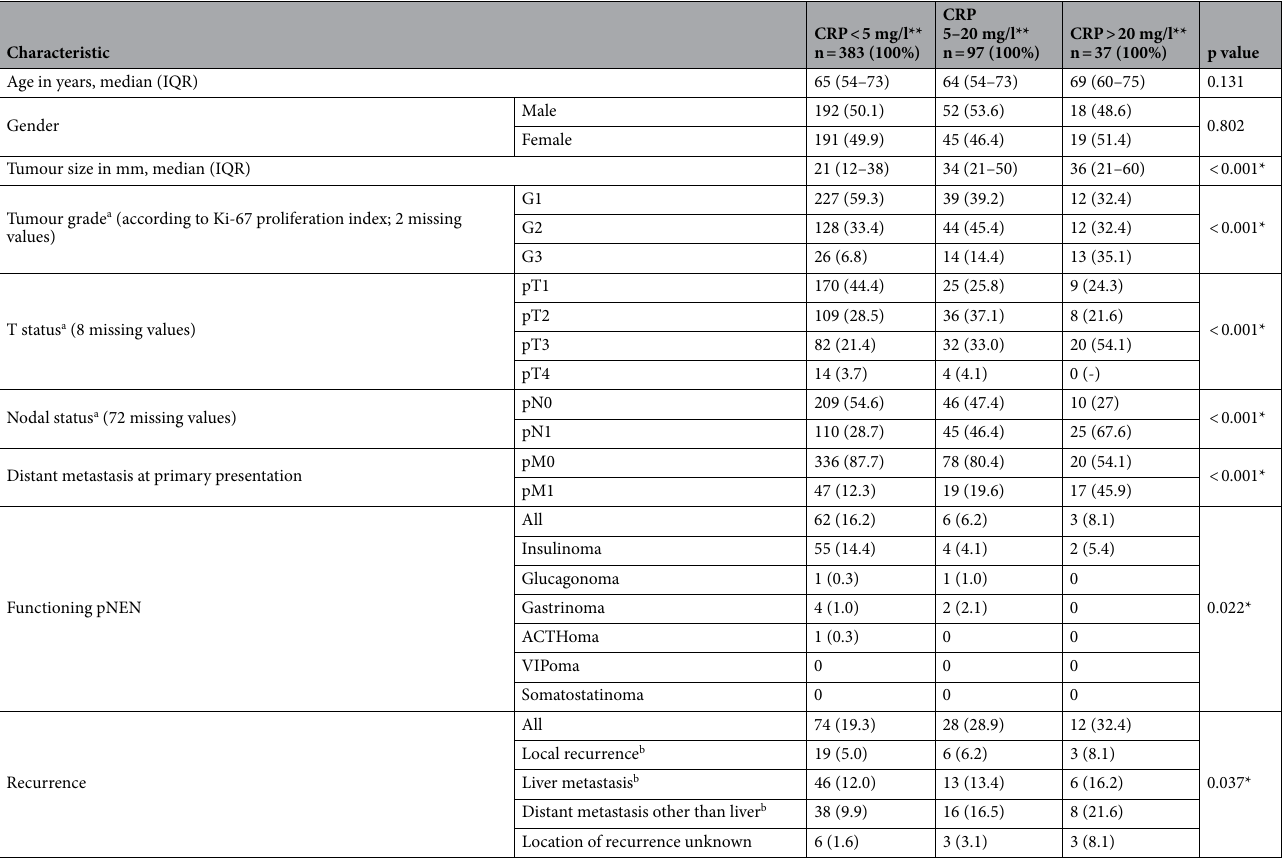
Table 1. Clinicopathologic characteristics and comparison between CRP groups. pNEN pancreatic neuroendocrine neoplasm, F- functioning, CRP C-reactive protein. *Statistically significant. **Measured 12–36 h prior to surgery. a 8th TNM. b Numbers in total, may include patients with both local and distant